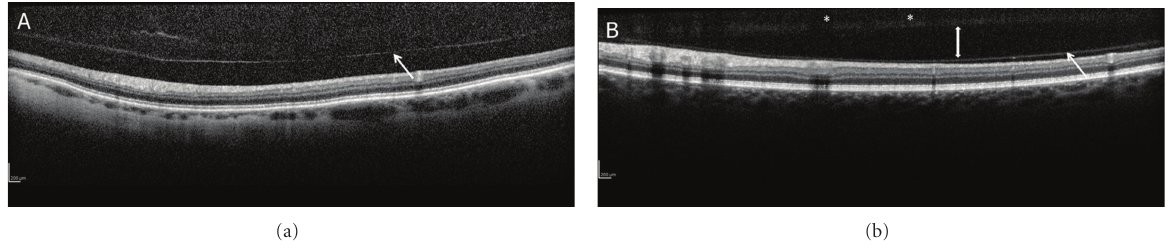
Figure 4: SD-OCT images of PVD and vitreoschisis. PVD; posterior hyaloid (arrow) separated from the retina (a). Vitreoschisis with liquefaction (double-head arrow) of the vitreous between a formed vitreous (asterisk) and an attached posterior hyaloid (arrow).